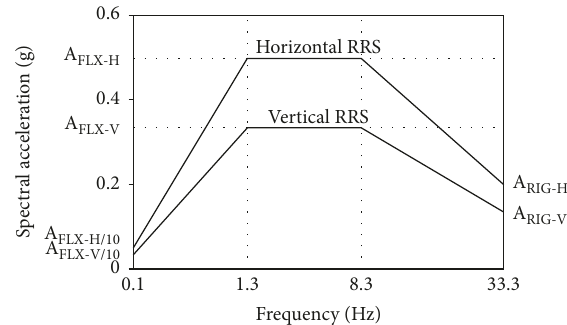
Figure 6: Required response spectrum specified by the AC156